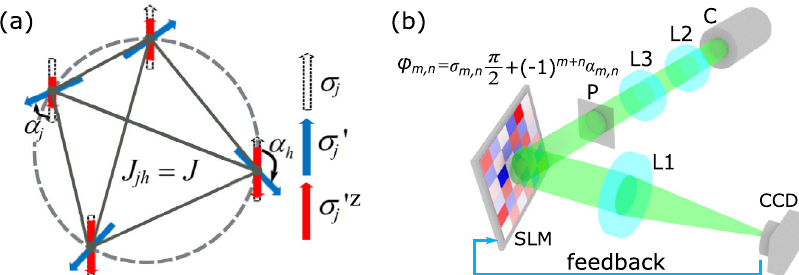
Fig. 1 Schematic representation of spatial photonic Ising machine (SPIM) with gauge transformation. a Schematic of the gauge transformation. The dotted, blue and red arrows correspond to the origin spin σ j , the new spin vector σ 0 and the effective spin vector σ 0 z , respectively. After clockwise rotating j j with respect to the z -axis with the angle α j , the interaction strengths J jh are uniform and equal to J . b The experimental optical setups for SPIM: SLM, spatial light modulator; CCD: charge-coupled device; C, collimator; L, lens; P, polarizer. A collimated laser beam illuminates the SLM. By gauge transformation, the gauge-transformed effective spin con fi guration S 0 z ¼ f σ 0 z g is encoded through a single phase-only SLM following Eq. (1), where φ m , n is the phase m ; n modulation and α ¼ arccos ξ for each spin. The modulated light is detected by a CCD camera in the back-focus plane of lens L1. m ; n m ; n